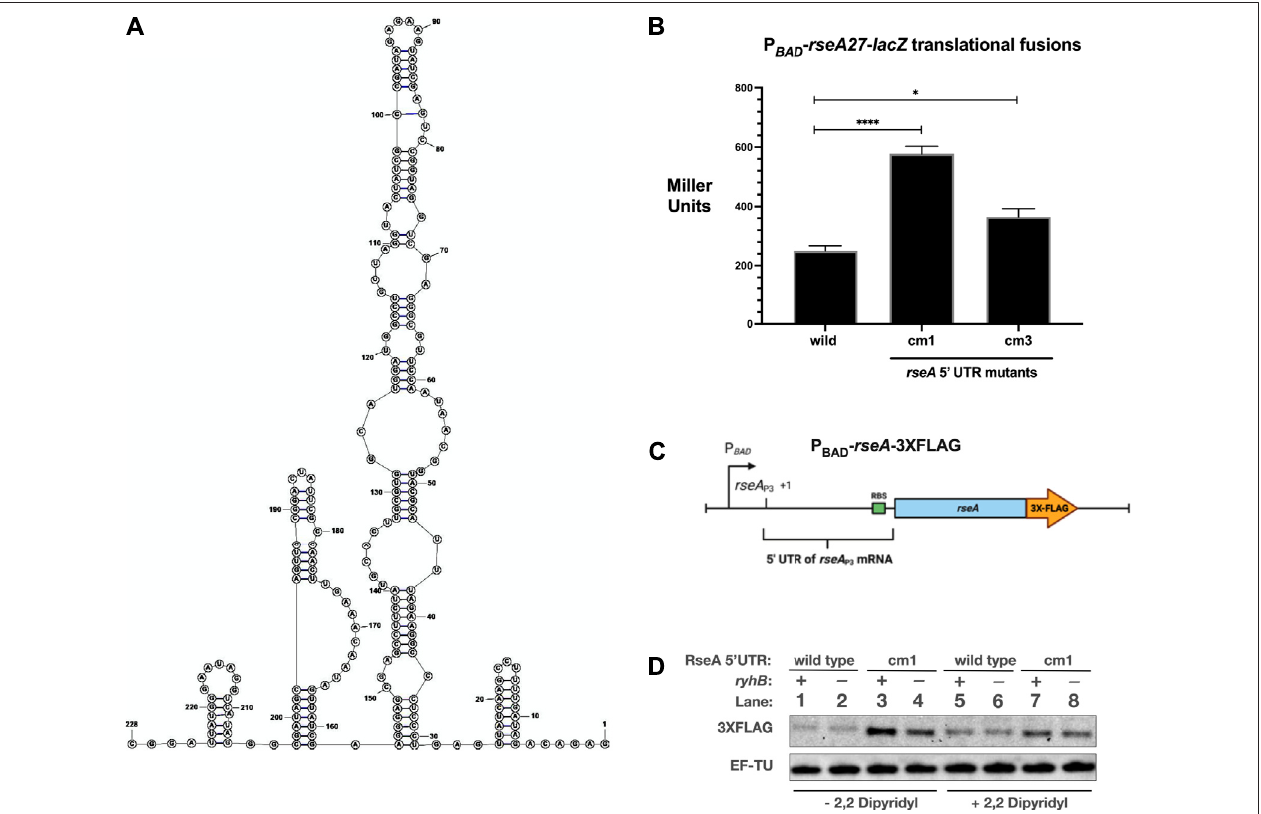
FIGURE4| 5 ′ UTRmutationsstimulateRseAtranslation (A) .PredictedstructureofRseA P3 5 ′ UTRusingRNAStructure (B) .Thewild-type,cm1,andcm3allelesof theP BAD -rseA27 - lacZ translationalfusionstrainsweregrowninrichmediatothemid-logphase(OD 600 of0.5),andaliquotswereisolatedfor β -galactosidaseactivity (C) . Schematic of the P BAD - rseA -3XFLAG allele utilized for the subsequent RseA-FLAG western blot (D) . RseA-FLAG western blot. The wild-type and cm1 P BAD - rseA - 3XFLAGstrainsweregrowninLBsupplementedwitharabinosetoa fi nalconcentrationof0.002%tothemid-logphaseandthentreatedwith2,2-dipyridyltoa fi